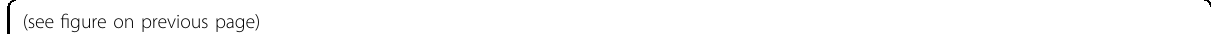
Fig. 2 BM-Tg210/R-wt muscles display impaired tissue repair, dysfunctional angiogenesis, and decreased calf perfusion after ischemia. A Representative H/E stained sections of ischemic gastrocnemius muscles of BM-wt/R-wt, BM-Tg210/R-Tg210, BM-Tg210/R-wt, and BM-wt/R-Tg210 mice. Magni fi cation ×200. Calibration bar 100 µm. Insets show magni fi cations of the indicated areas. Green arrows indicate capillaries; black asterisks indicate areas of in fl ammation, green asterisks indicate degenerating myo fi bers, red asterisks indicate regenerating myo fi bers (i.e., small myo fi bers with central nucleus) and yellow asterisks indicate extravasated erythrocytes. B Capillary density quanti fi cation ( n = 16 – 18, Anova multiple comparison ** P < 0.002, # P < 0.0001). C Representative α -SMA immunohistochemistry of ischemic gastrocnemius muscles of BM-wt/R-wt, BM-Tg210/ R-Tg210, BM-Tg210/R-wt, and BM-wt/R-Tg210 mice. Red arrows indicate arterioles. Magni fi cation ×200, calibration bar 100 µm. D , E Arteriolar length density (ALD) quanti fi cation. Arterioles were classi fi ed on the basis of the minimum internal diameter as small (4 – 10.99 μ m in D ) and medium (11 – 20.99 μ m in E ) ( n = 16 – 18 Anova multiple comparison * P < 0.05; ** P < 0.002; *** P < 0.0007). F Calf perfusion was monitored by ultrasound in power Doppler mode and expressed as vascularity ratio of ischemic/non-ischemic limbs ( n = 16 – 18, Anova multiple comparison * P < 0.05; *** P < 0.0001). G Macrophage density quanti fi cation ( N = 16 – 18, Kruskal – Wallis test, multiple comparison P <